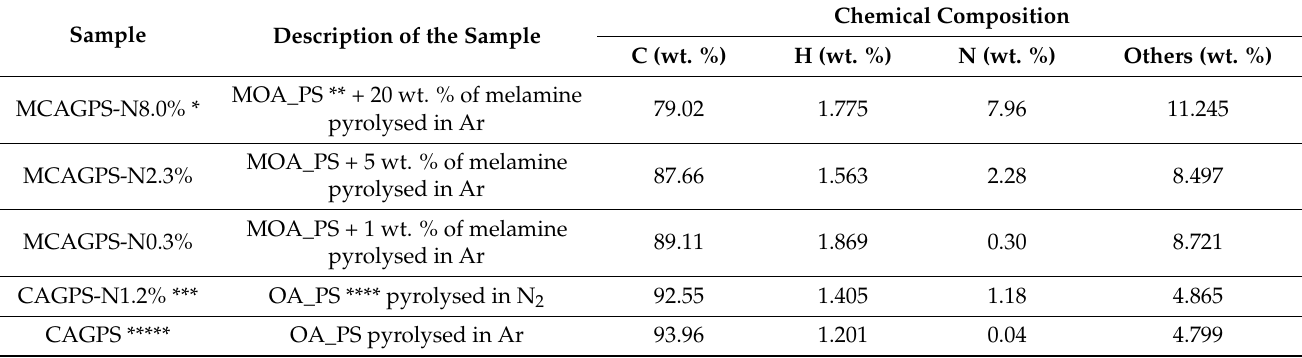
Table 1. Elemental analysis results of nitrogen-doped and pure carbon aerogels.